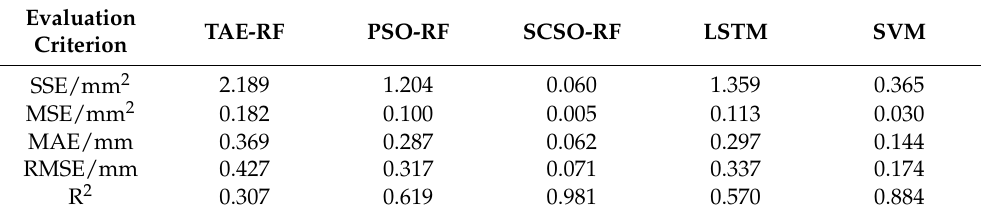
Table 5. Comparison of prediction performance of models at the specified